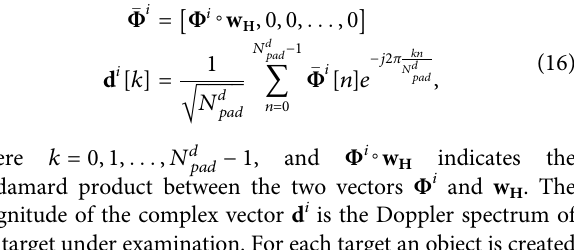
Frontiers in Signal Processing |